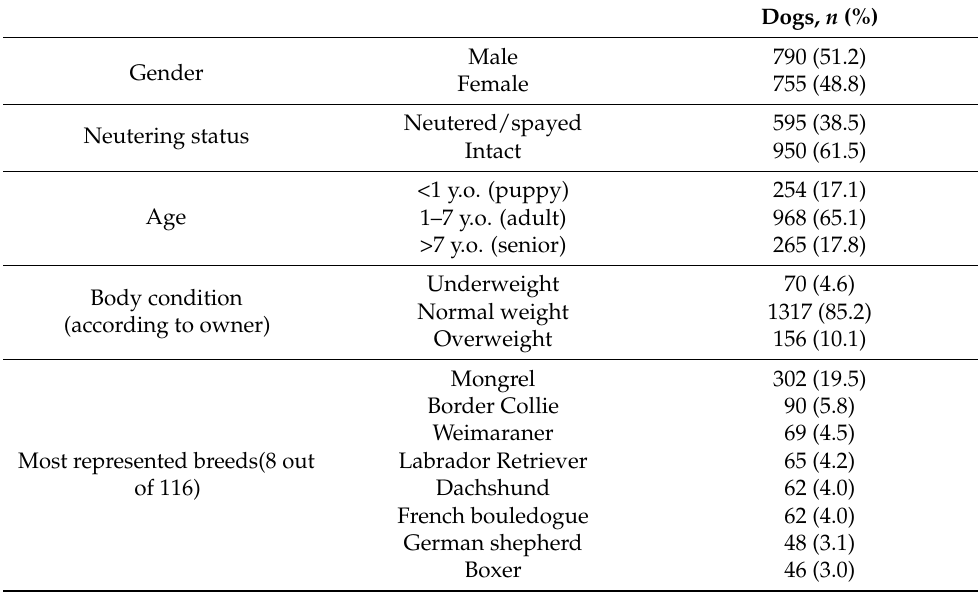
Table 2. Characteristics of dogs enrolled in the study ( n =